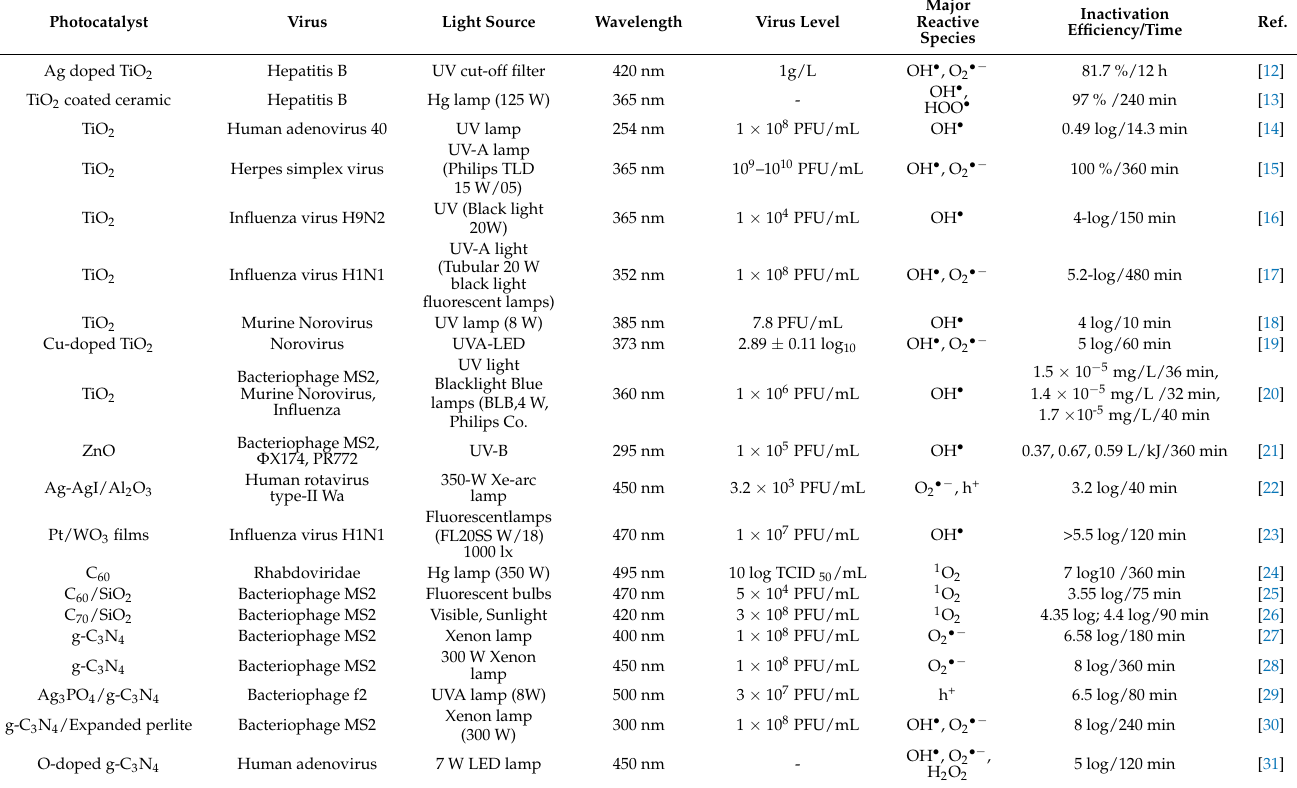
Table 1. Summary of potential photocatalysts for virus